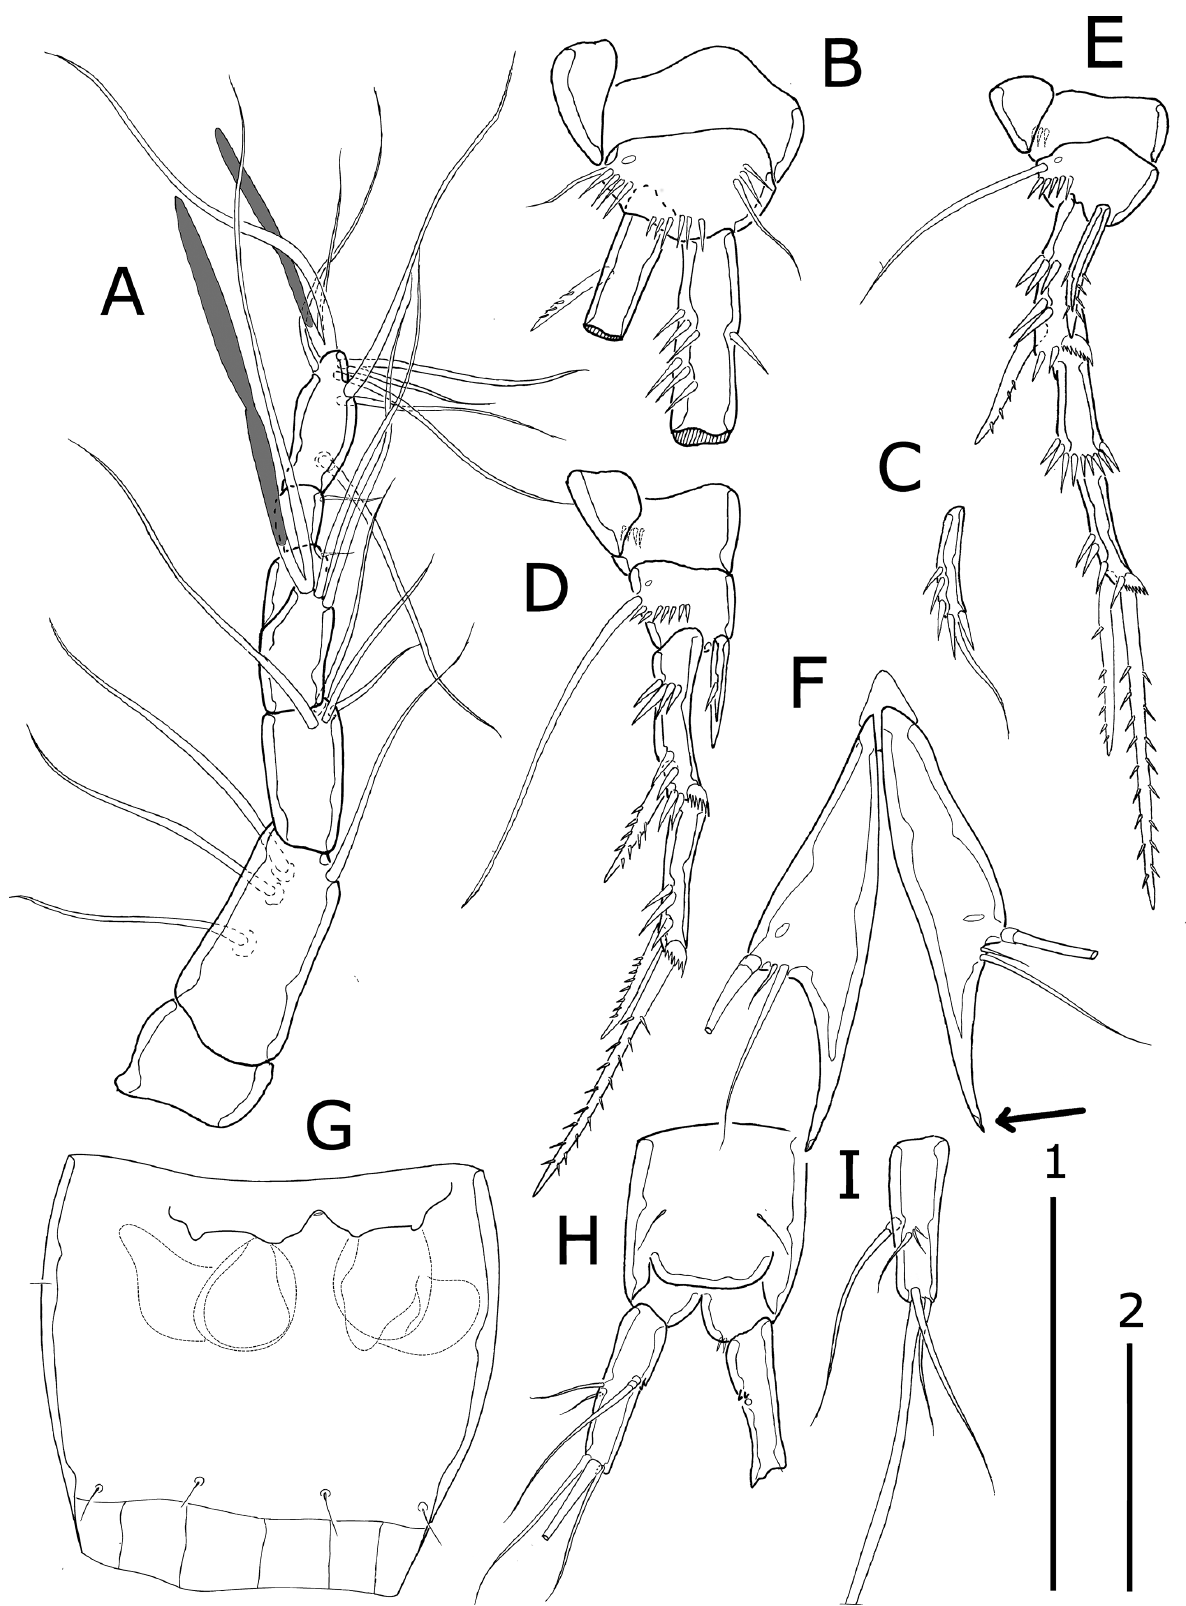
Figure 4. Eirinicaris antonioi sp. n. Female: A antennule; B P1, depicted with coxa, basis enp-1 and exp-1; C P2 enp; D P3, ante- rior; E P4 anterior; F P5, with distal pore arrowed; G genital field; H anal somite with caudal furca; I furca, lateral view. Scale bar 1 ( A, F ) and 2 ( C, D, E, G, H, I ) =